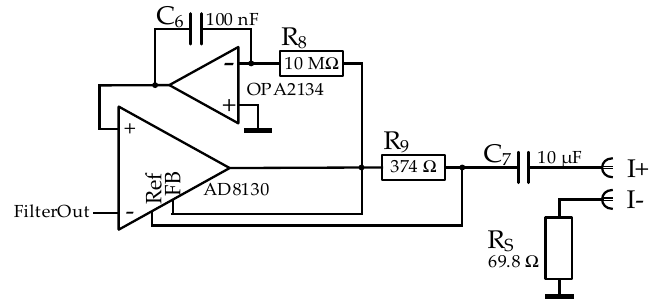
Figure 4. Circuit diagram of the implemented voltage-controlled current source.